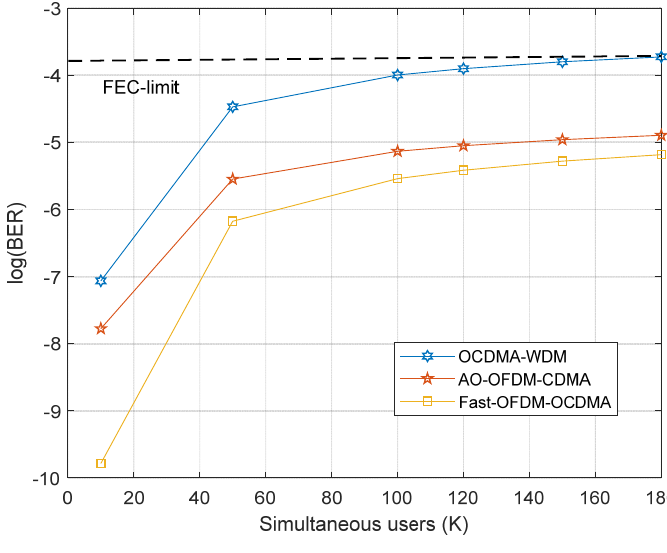
Figure 3. BER versus simultaneous users.